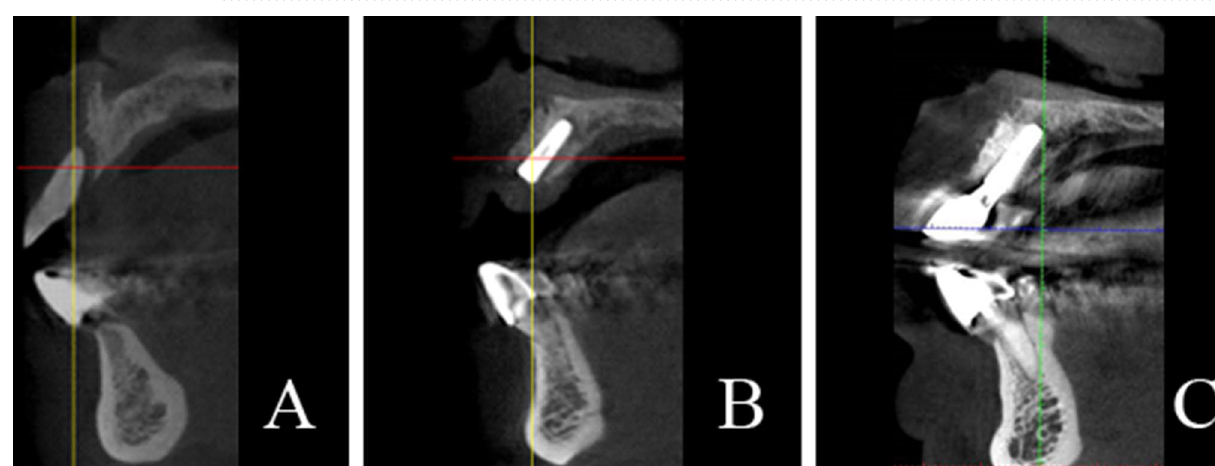
Figure 2. ( A ) Cone-beam computed tomography (CBCT) pictures showing bone defect preoperation; ( B ) bone profile with an implant and xenogeneic bone ring after 6 months after the surgery; ( C ) bone profile with implant 1 year after